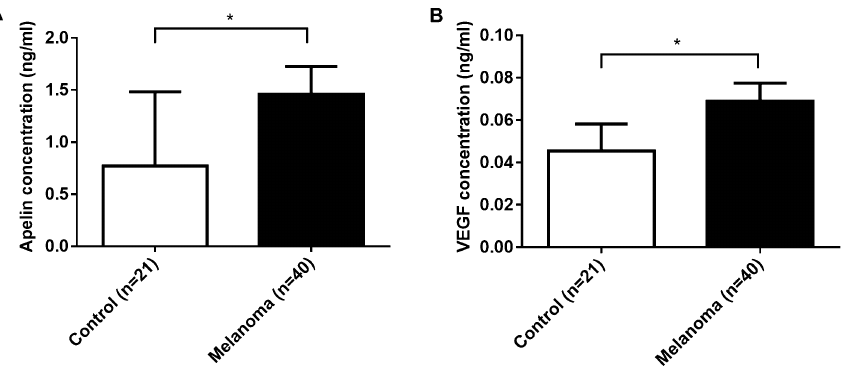
Figure 5. Apelin and VEGF plasma levels are elevated in patients with melanoma vs. healthy group. ( A ) Plasma apelin levels were significantly elevated in patients with melanoma (n = 40) compared to those in the healthy group (n = 21) (1.4590 ± 0.2676 ng/ml vs. 0.7704 ± 0.7117 ng/ml, respectively, p = 0.0011). ( B ) Plasma VEGF levels were significantly higher in patients with melanoma (vs. healthy controls), (0.0689 ± 0.0086 ng/ml vs. 0.0454 ± 0.0128, respectively, p < 0.0001). * p <